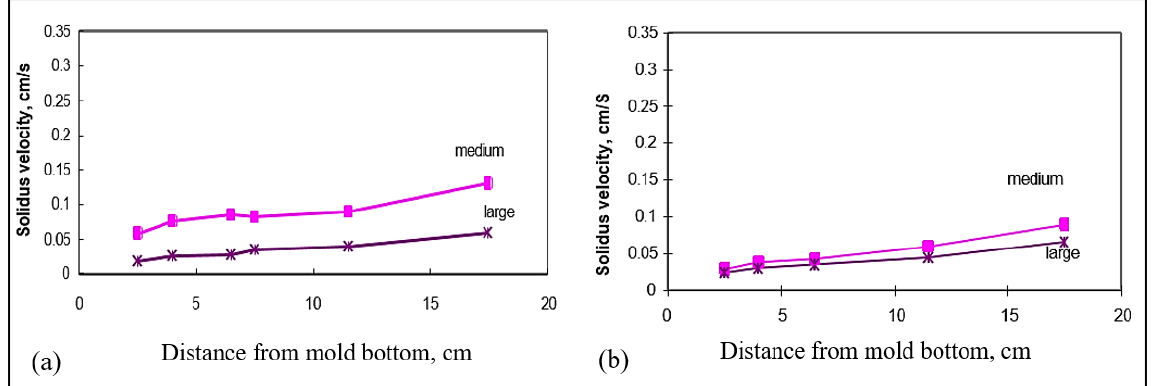
Figure 19. Average vertical solidus interface velocities in the wedge mold as a function of the distance from the bottom of the mold for ( a ) BC2 alloy (B + 103 ppm Ca), and ( b ) CC2 alloy (C + 94 ppm Ca), for medium and large